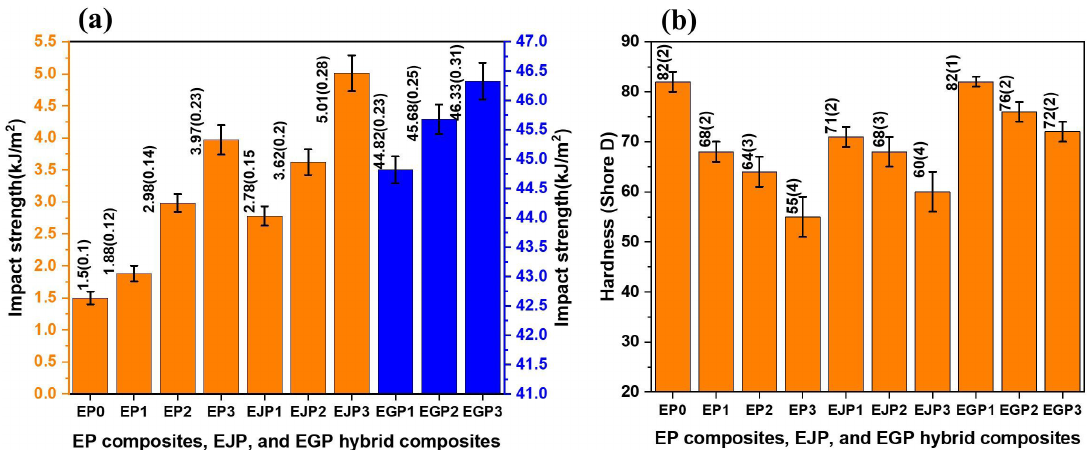
Figure 4. Mechanical characteristics of Epoxy, EP composites, and their hybrid composites: (a) Impact strength, (b) Hardness.